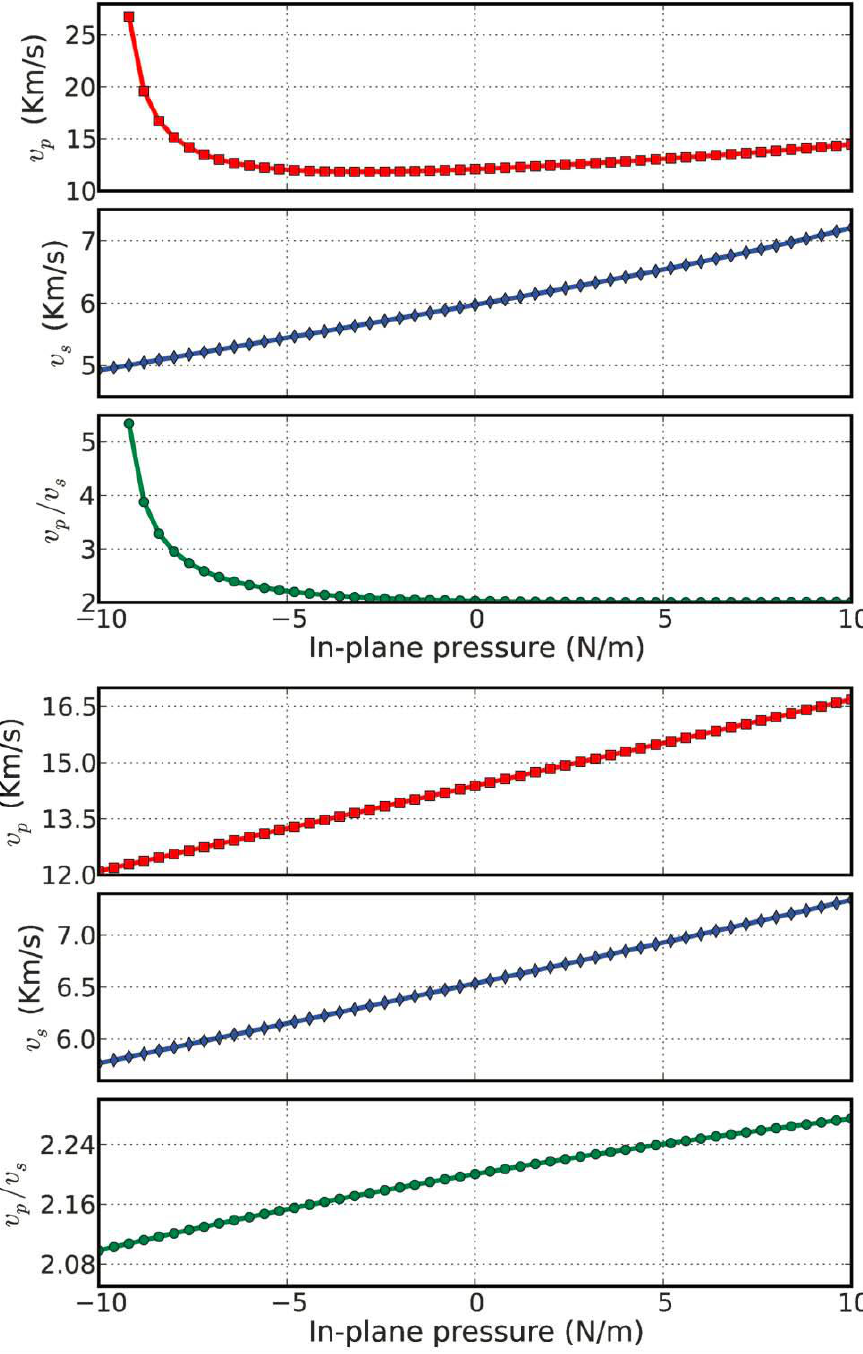
Figure 13. p-wave and s-wave velocities, and compressional to shear wave velocity ratio ν p / ν s as a function of in-plane pressure for g-AlN ( top ), compared with g-BN ( bottom ). The ratio of ν p / ν s monotonically decreases with increasing pressure as shown in Figure 13. It converges to a value of 2.0 at positive